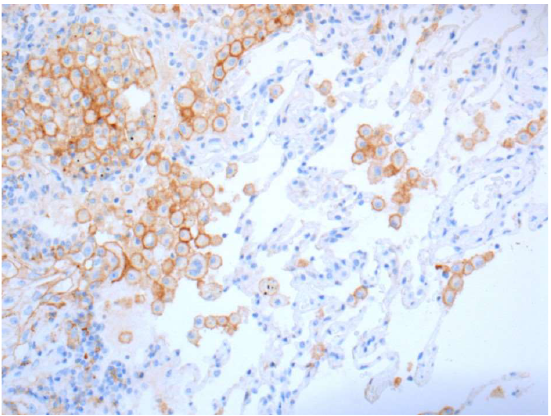
Figure 4. Positive stainings of alveolar macrophages are not counted but are useful as positive control (20 × Obj.).